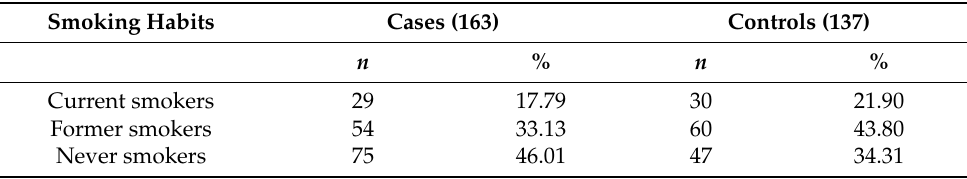
Table 6. Descriptive characteristics of smoking status stratified by disease. Smoking